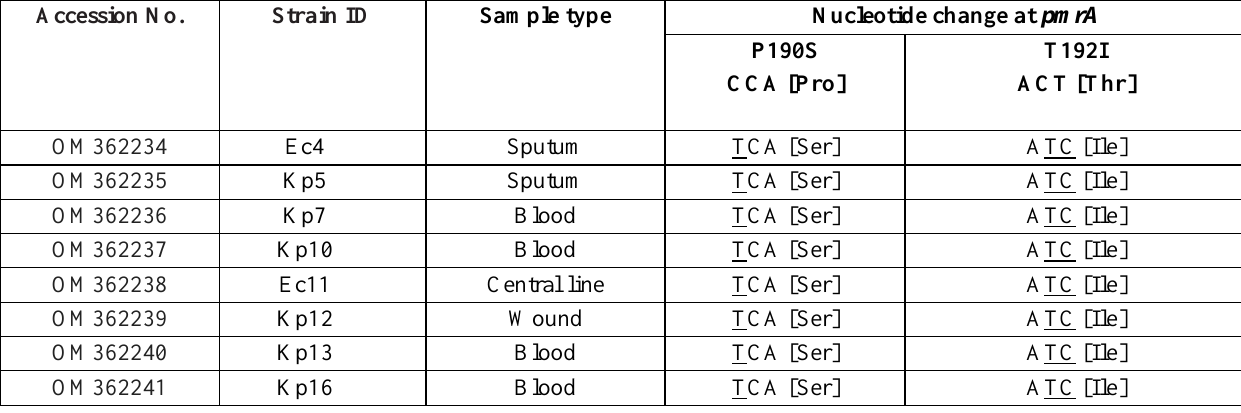
Table 7. Accession number and source of mutated pmrA gene among colistin resistant K. pneumoniae and E. coli. Accession No.